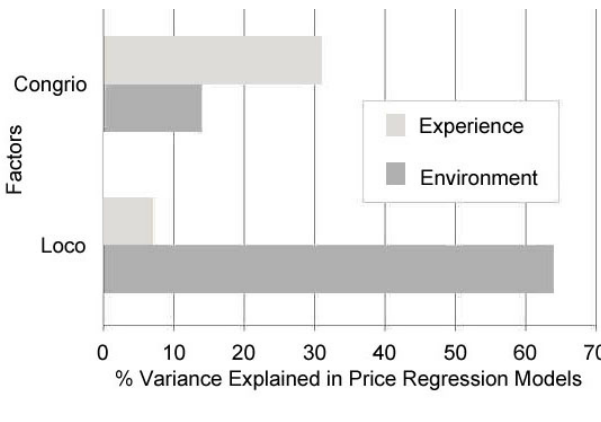
Fig. 4 . Percent variance in price explained by environmental and experience factors for the loco and congrio